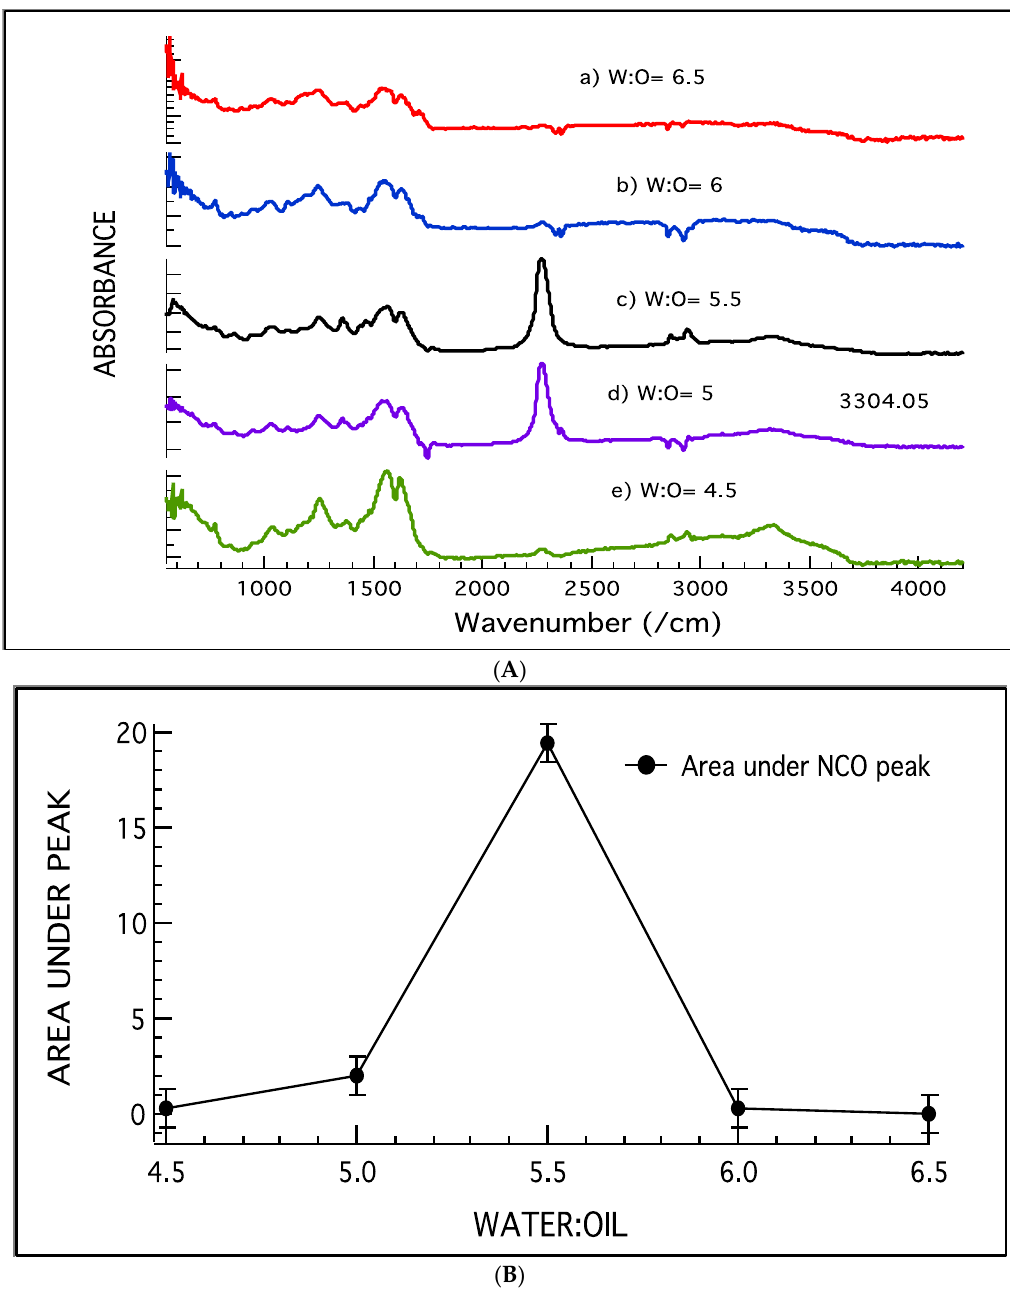
Figure 2. ( A ) FTIR of samples with water-to-oil ratio of 4.5:1 to 6.5:1. ( B ) The area under NCO peak as a function of water-to-oil ratio used in synthesis of microcapsules. Microcapsules with a water-to-oil ratio of 6.5:1 showed a negligible NCO peak, thus con fi rming that encapsulation did not take place. The presence of CH symmetric stretch- ing, CH asymmetric stretching, NH deformation, CN stretching, and NH stretching at 2849 cm − 1 , 2917 cm − 1 , 1498 cm − 1 , 1600 cm − 1 , and 3220 cm − 1 , respectively, showed the pres- ence of polyurea and PUF. Figure 2B shows the area under the NCO peak of microcapsules with water-to-oil ratios of 4.5:1, 5:1, 5.5:1, 6:1 and 6.5:1. From Figure 2B, it is clear that the amount of NCO